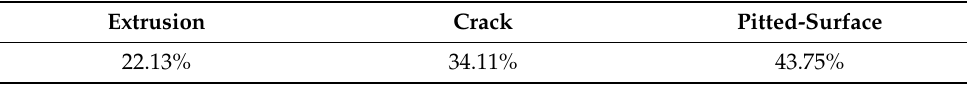
Table 4. The ratio of extrusion, crack, and pitted-surface in